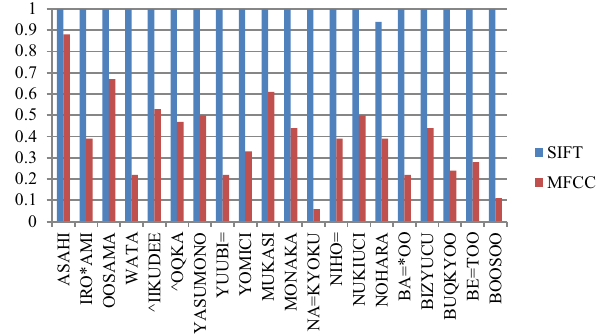
Fig. 9 Correct classification rate of LNBNN with MFCC and SIFT features on the TMW database